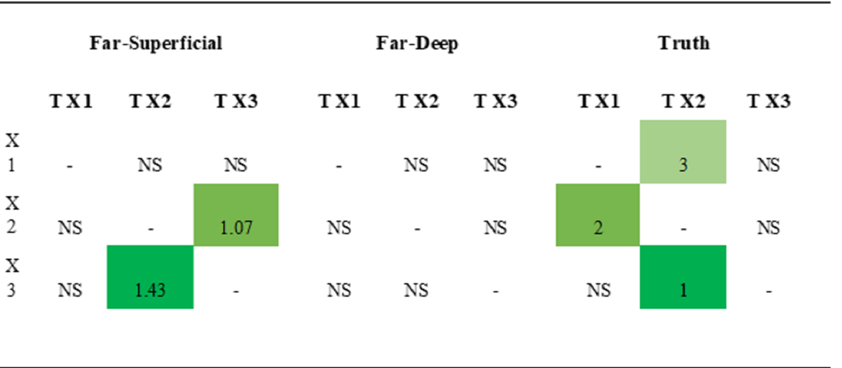
Figure 9. TCDF, Mean attention score rankings. Colors: “1”, green, denoting the highest attention score in one TCN—one column). The columns represent the targets (T X1, T X2, T X3), the rows the predictors (X1, X2, X3). Self-connectivity is excluded.